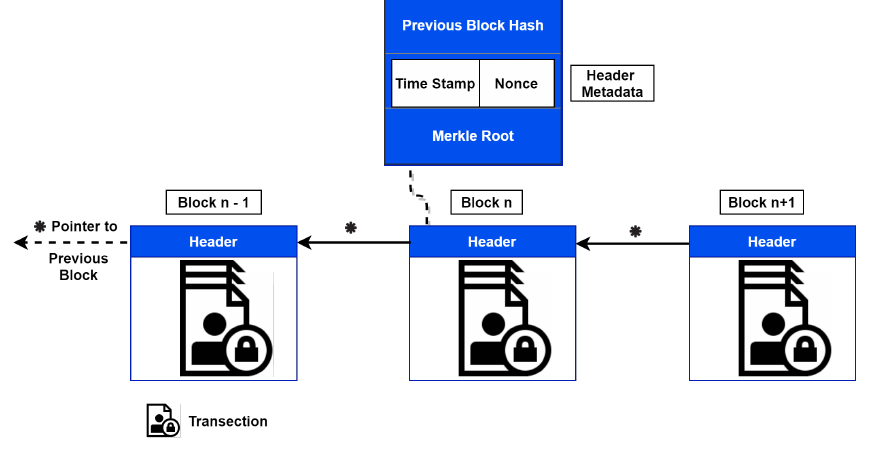
Figure 2. Composition of a